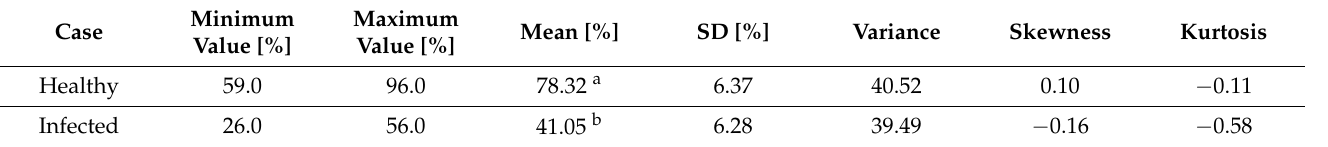
Table 1. Results of calculations and statistical analysis for the tested cases: healthy and infected